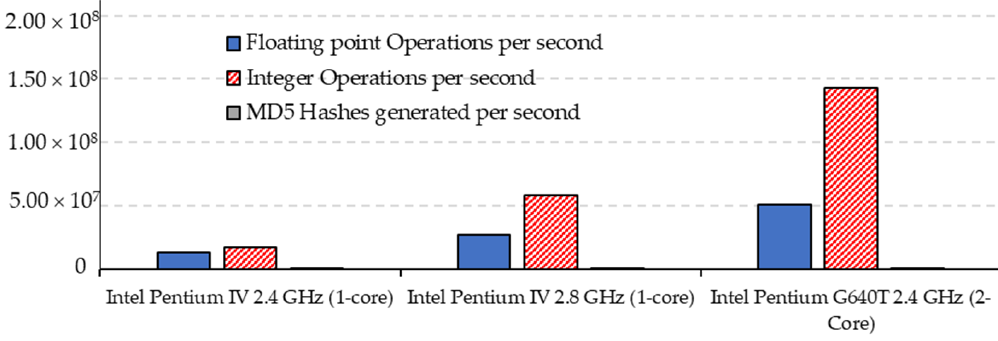
Figure 7. Comparison between CPU operations per second for single core and dual core.